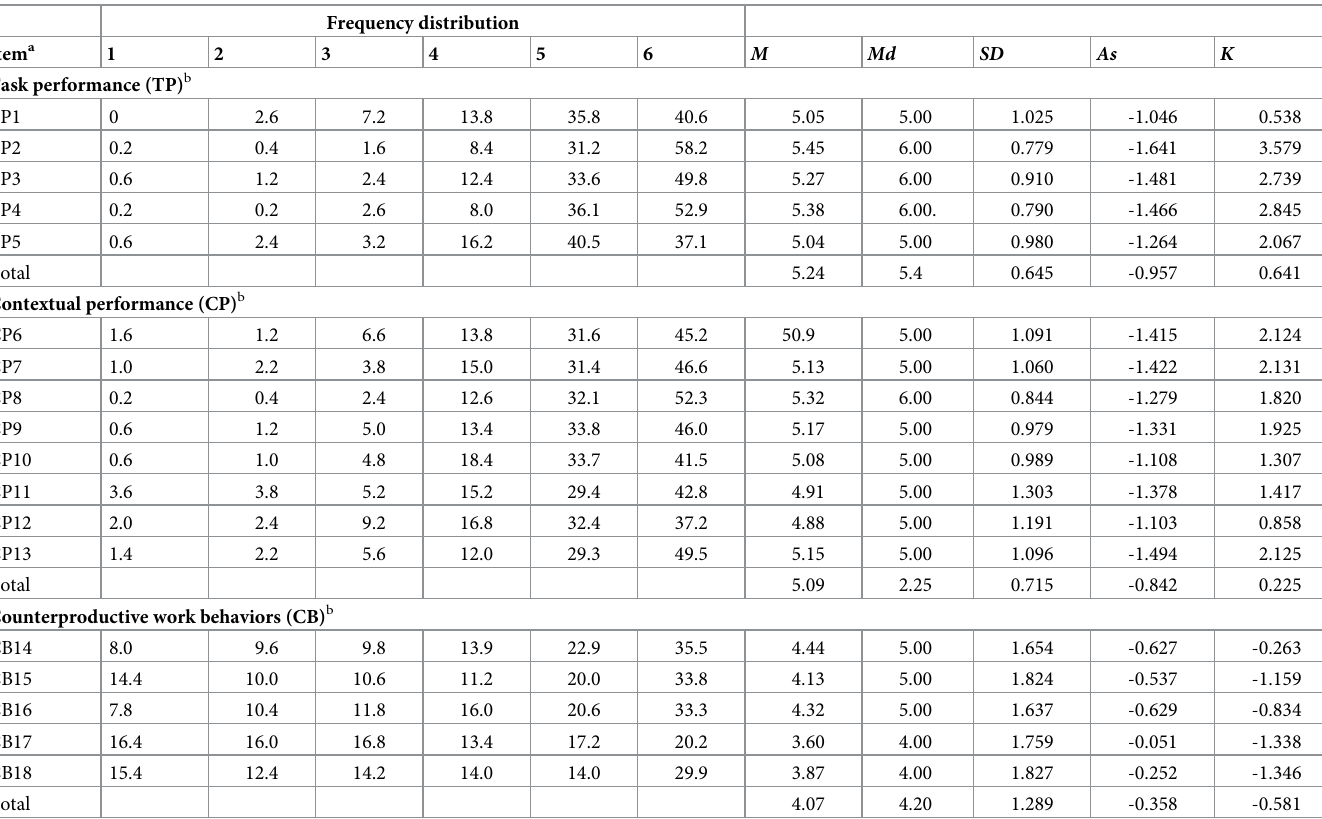
Table 2. Frequency distribution and descriptive statistics of each item of IWPQ-Version 1.0.